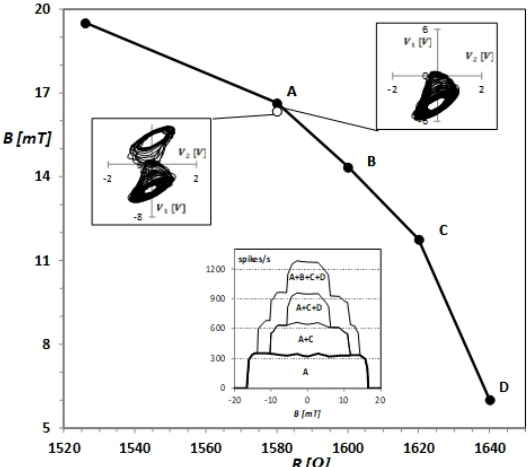
Figure 5. The experimental dependence of the static magnetic field intensity B on the resistivity R at the bifurcation threshold. The upper insets show phase portraits of Chua’s circuit corresponding to examples of V 1 ( t ) shown in Figure 2 for B equal to 16.34 mT and 16.63 mT. The lower inset presents transfer functions of sensors consisting of 1, 2, 3 and 4 Chua’s circuits with resistivities corresponding to points A–D and the output obtained by summing their spike count rates in 10 s time window.